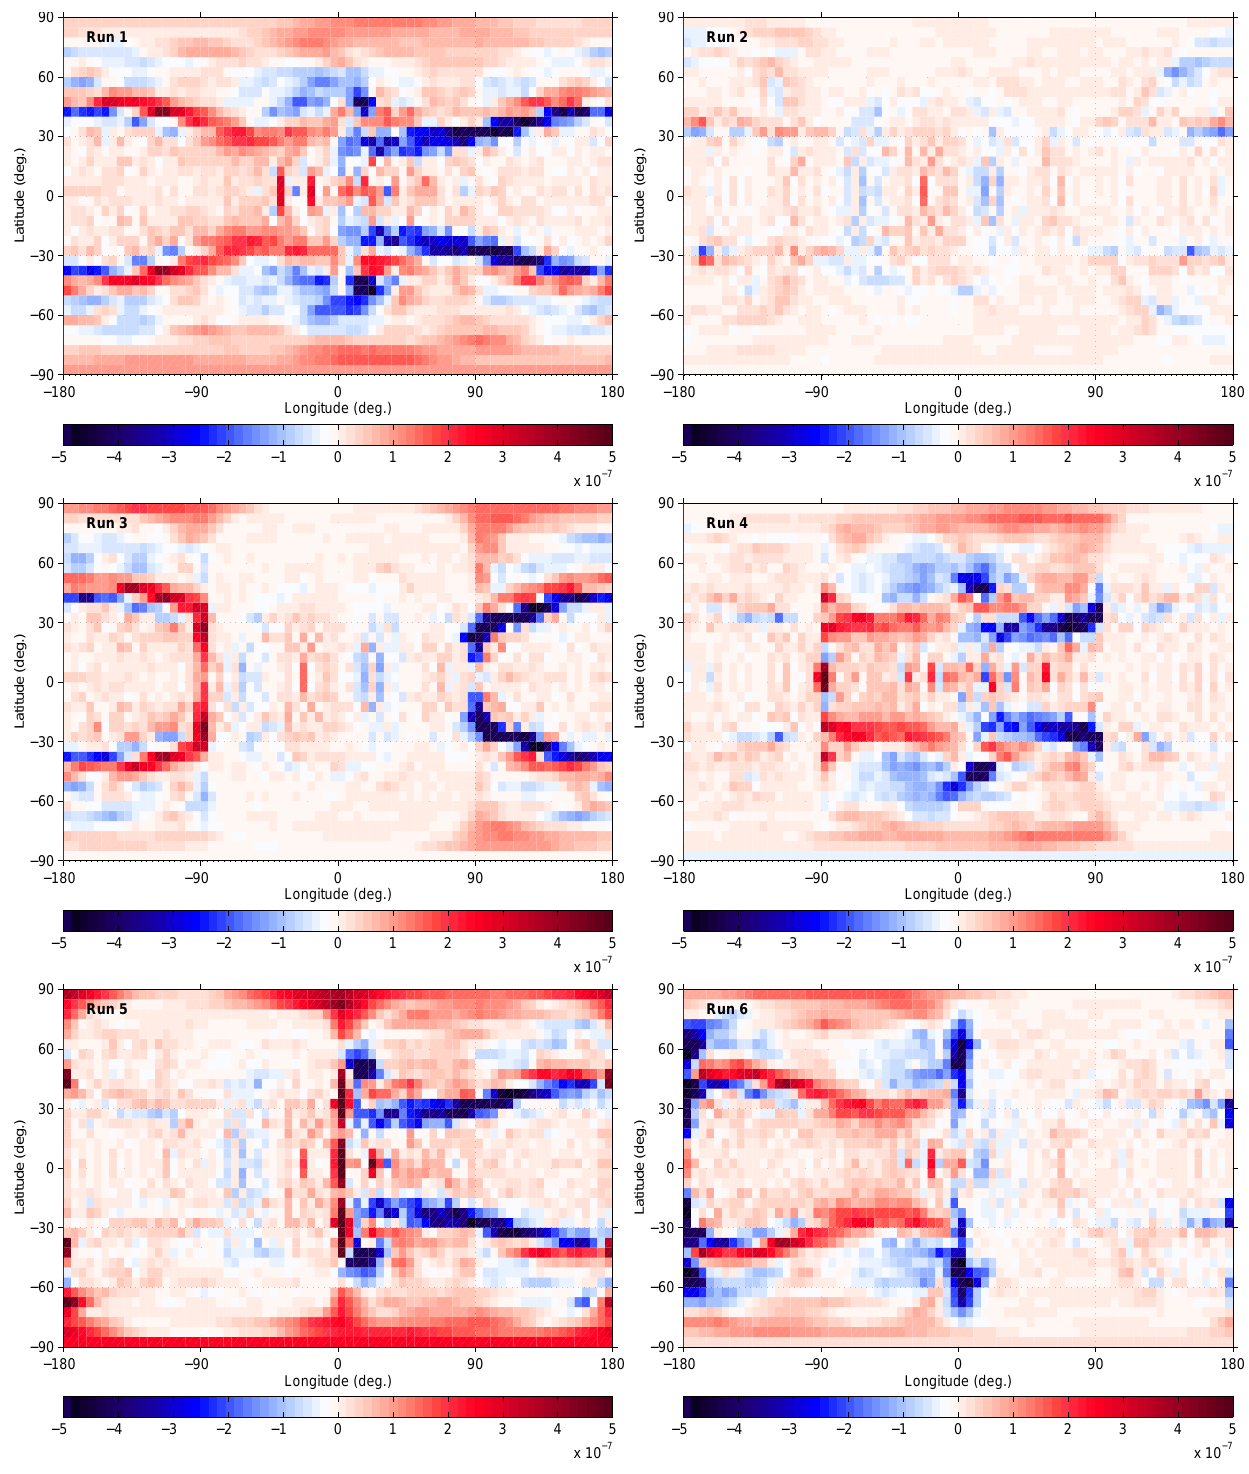
Fig. 2. Current density (A m − 2 ) entering the planet as a function of latitude and longitude in all runs. Zero longitude corresponds to noon and positive longitude to duskside. Positive current (red) is towards the planet and negative (blue) is away from the